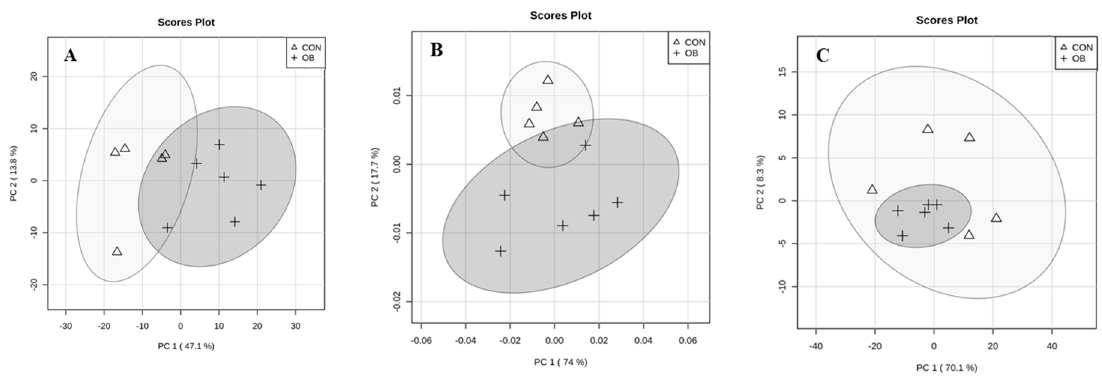
Figure 1. Principal component analysis of ( A ) plasma, ( B ) liver, and ( C ) muscle nuclear magnetic resonance results. Triangle: control sows (CON); cross: obese sows (OB). resonance results. Triangle: control sows (CON); cross: obese sows